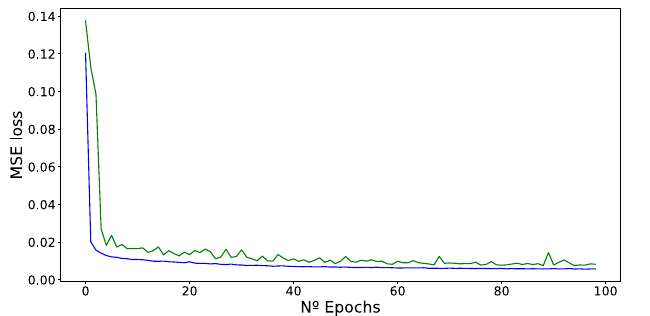
Figure 12. Training (blue line) and validation (green line) MSE loss evolution for successive epochs while training (model: DL architecture (1 LSTM + 1 FC) ( 𝑓 = 1, 𝑝 = 168, 𝑘 = 24)).